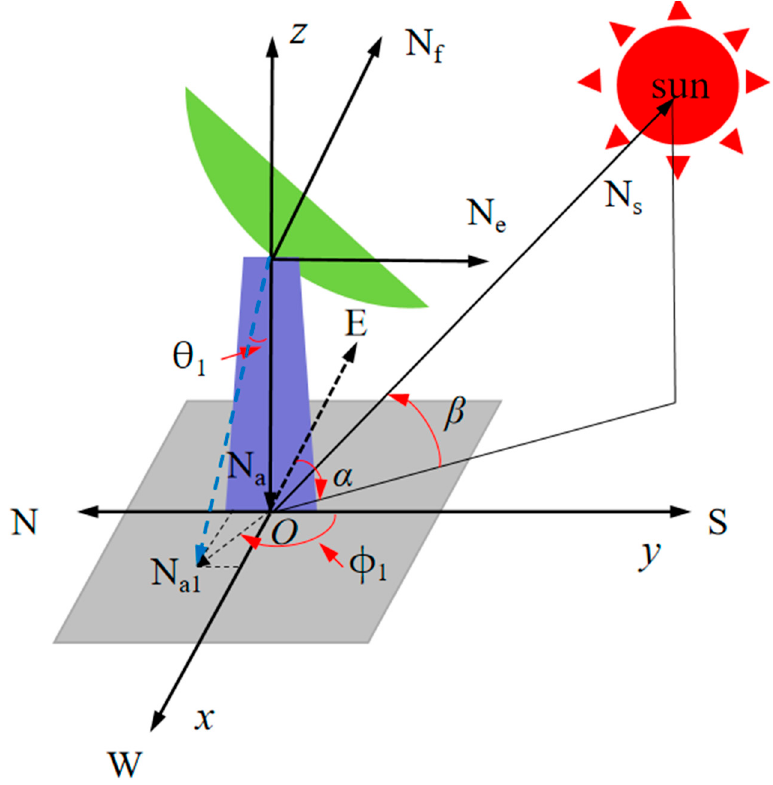
Figure 2. Schematic diagram of the azimuth axis tilt error. Based on the rigid body motion theory [27], the column tilt is equivalent to the azimuth axis vector rotating by a certain radial angle and tangential angle, in turn. The azimuth axis produces the tilt error, which can be considered as the ideal azimuth axis vector Na rotating by an angle θ 1 around the x -axis and then rotating by an angle φ 1 around the z -axis. The azimuth axis vector N a1 , after introducing the tilt error, is shown in Equation (1), where Rot(x, θ 1 ) and Rot(z, φ 1 ), respectively, represent the rotation matrix around the x- and z -axes, which are shown in Equations (2) and (3), respectively: